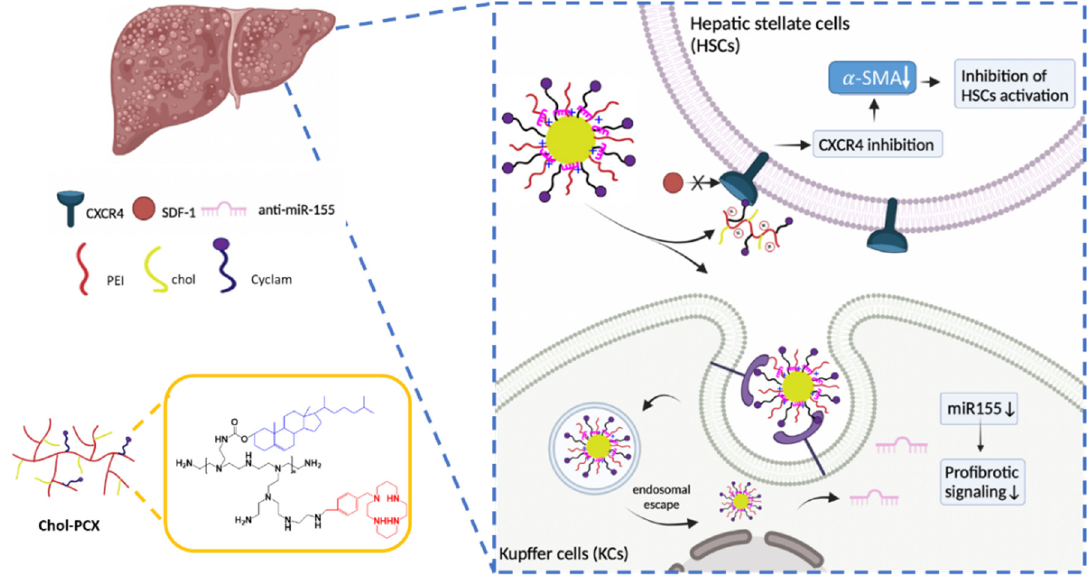
Figure 1. Schematic illustration of the mechanisms of the antifibrotic effect of Chol-PCX/anti-miR-155.